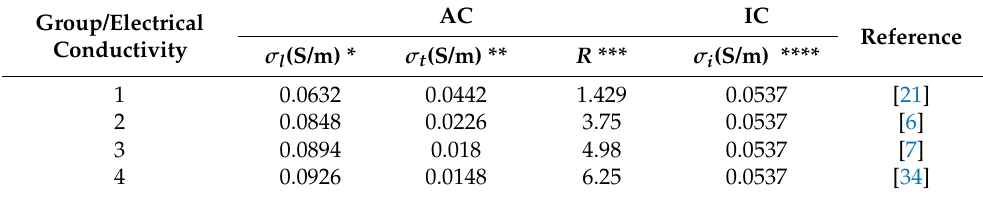
Table 2. Four groups of myocardial AC and the corresponding